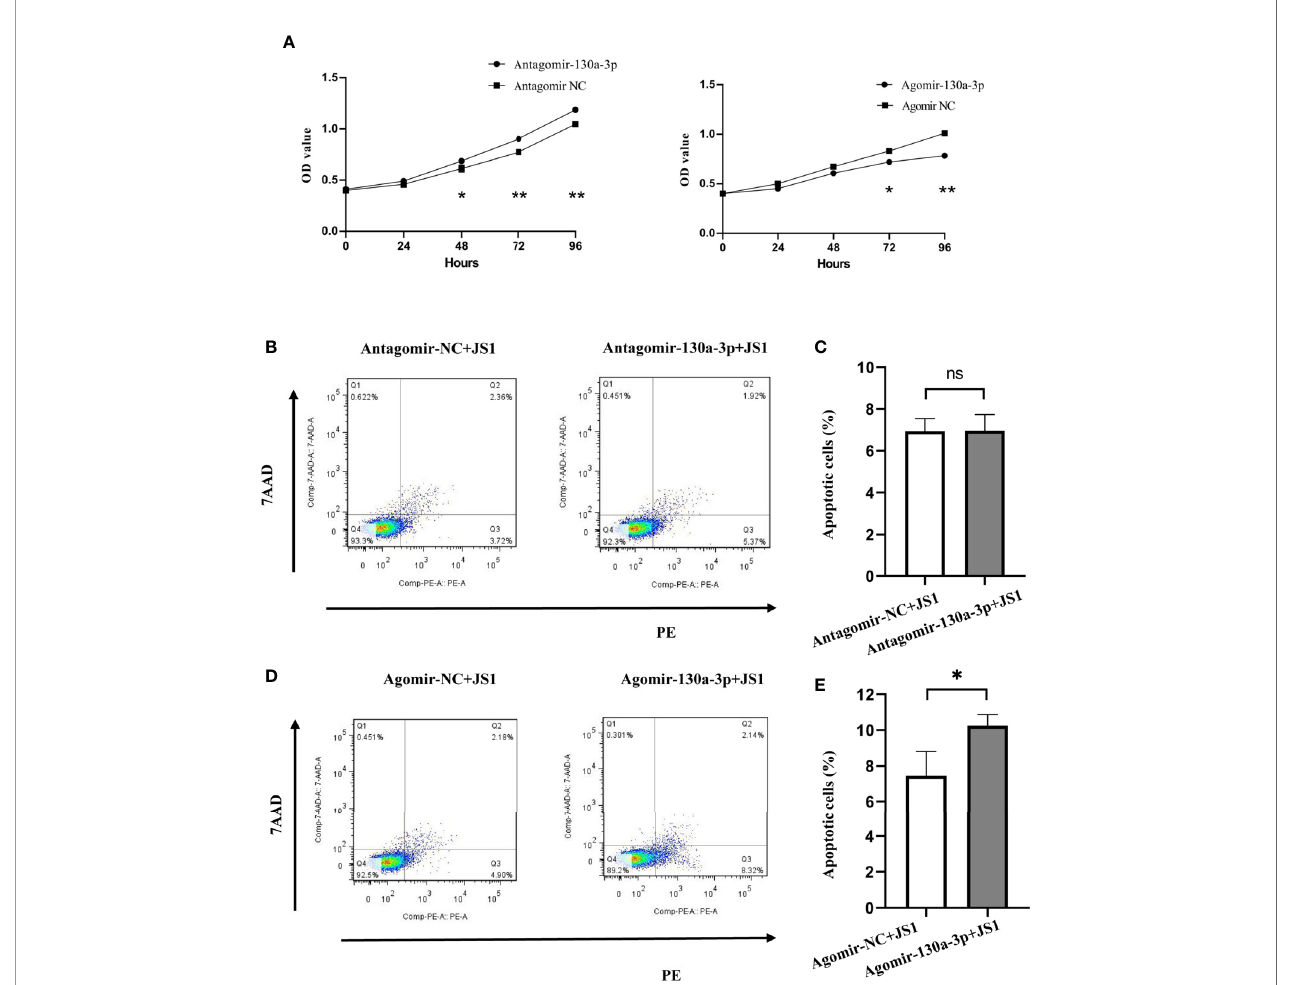
FIGURE 6 | Overexpression of miR-130a-3p inhibited the proliferation and growth, and induced apoptosis of JS1. The proliferation of transfected JS1 cells was tested at 0, 24, 48, 72, and 96 h by CCK8 assay (A) . The transfected JS1 cells were collected after 72 h; cell apoptosis was assessed by FCM (B – E) . Data represent mean±SD from multigroup experiments. * p <0.5 (n=4 each group). ** p < 0.01; ns, no signi fi